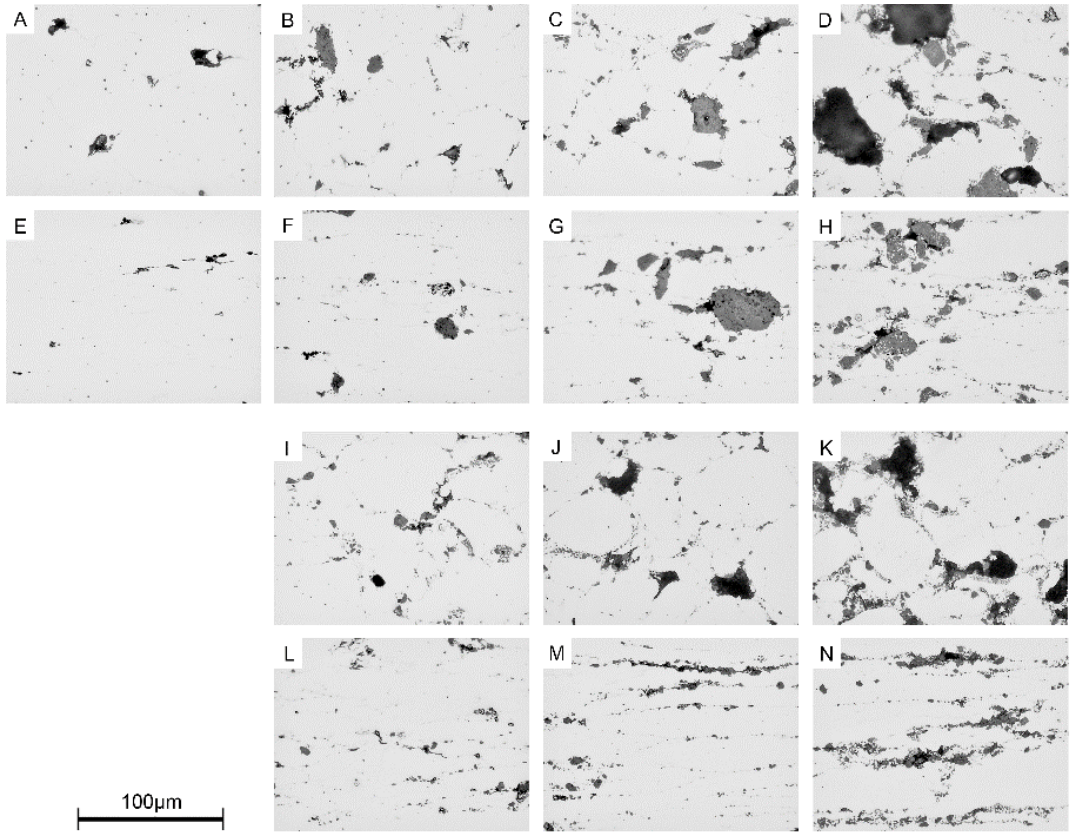
Figure 3. Sequence of unetched microstructures of as-sintered alloys ( A ) Base, ( B ) 2C, ( C ) 5C and ( D ) 10C contrasted by their hot worked counterpart in ( E ) base, ( F ) 2C, ( G ) 5C and ( H ) 10C. Additionally, a similar contrasting sequence of as sintered microstructures for ( I ) 2F, ( J ) 5F ( K ) 10F are shown with their forged counterparts in ( L ) 2F, ( M ) 5F and ( N ) 10F. All hot worked samples were processed at 400 °C and 0.05 s −1 to a strain of 0.70 mm/mm.